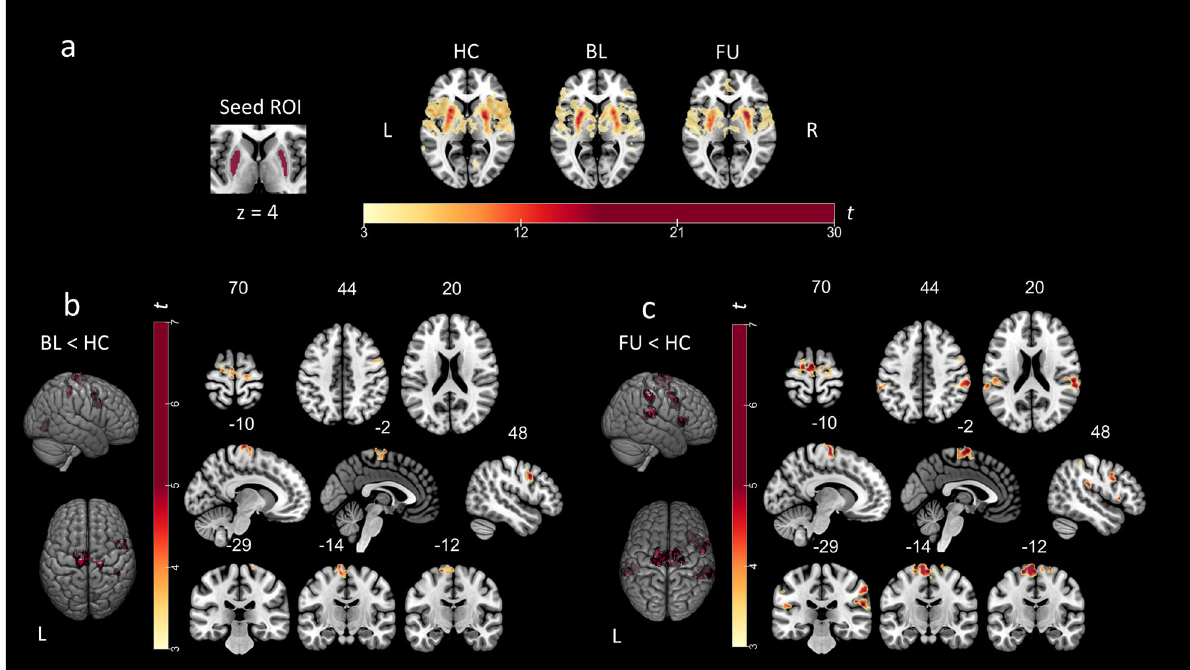
Fig. 4 Within- and between-group striatocortical functional connectivity of dopamine-depleted putamina. Top : a Putaminal seed-to-voxel functional connectivity maps of healthy controls and patients with PD at baseline and follow-up visit. Scaled colorbar indicates t -values. b Bottom left : Signi fi cant differences in putaminal functional connectivity between healthy controls and patients at baseline visit. Bottom right : Signi fi cant differences in putaminal functional connectivity between healthy controls and patients at follow-up visit. Study-speci fi c seed ROIs were provided by clusters derived from the FDOPA-PET comparison (FU < HC). SPM t -maps are overlaid on a T1 MNI template. All results were thresholded at